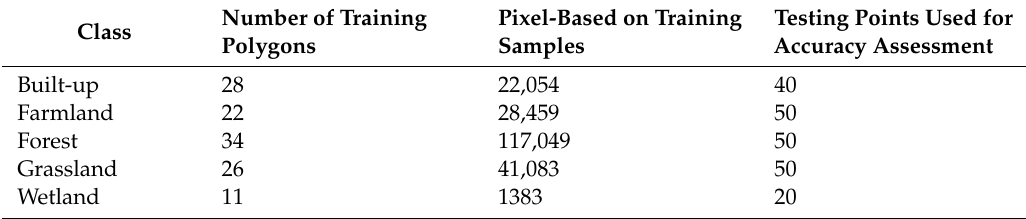
Table 3. Training polygons, samples and testing points for year